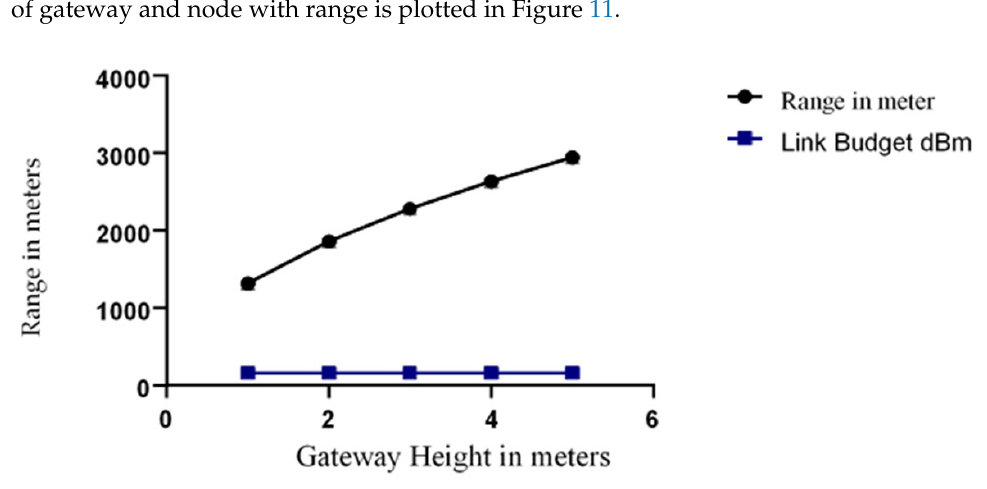
Figure 11. Gateway height versus range in meters.